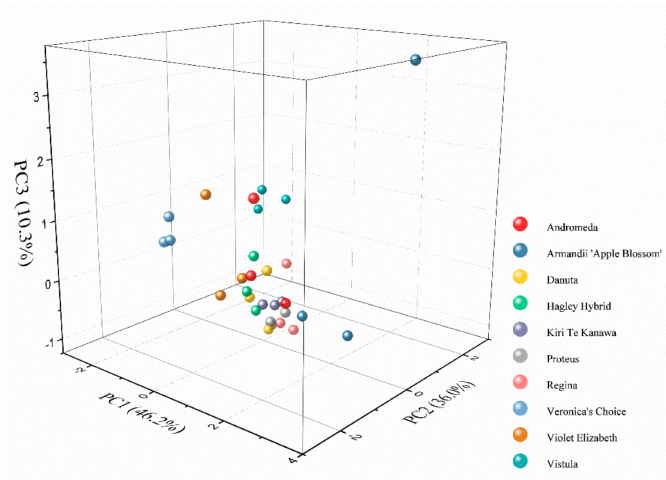
Figure 7. 3D principal component analysis (PCA) analysis of Vistula, Andromeda, Danuta, Armandii ‘Apple Blossom,’ Proteus, Hagley Hybrid, Violet Elizabeth, Kiri Te Kanawa, Regina, and Veronica’s Choice using normalized current recorded after two solvent extractions under two buffer solution